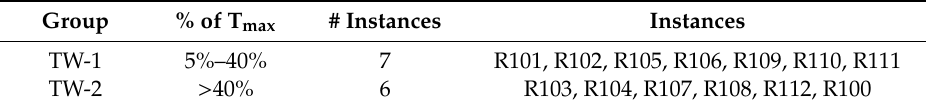
Table 2. Classification of investigated instances in TW-pattern groups based on TW width (% of T max ).